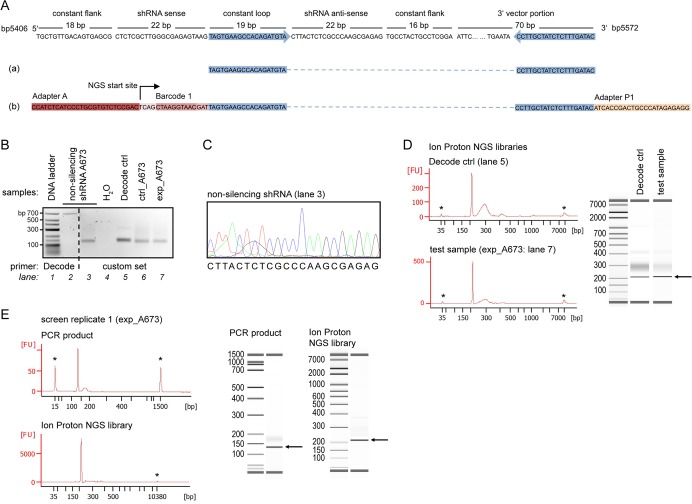
Anti-sense shRNA recovery and Ion Proton NGS library preparation.(A) Excerpt of the GIPZ plasmid sequence with non-silencing shRNA insert indicating primer locations, anti-sense shRNA amplicon (a), and Ion Proton NGS template (b). (B) Gel electrophoresis of anti-sense shRNA PCR products. A673 cells containing non-silencing shRNA (lanes 2–3) were processed identical to A673 test samples (lanes 6–7). For Decode ctrl template (lane 5), cDNA was transcribed from lentiviral particles. Decode Primer PCR (lane 2) followed its manufacturer’s protocol, for custom PCR see Materials and Methods. (C) Sanger-sequence of PCR product recovered from A673 cells that contained non-silencing shRNA (B; lane 3). (D) Bioanalyzer electrophoresis profiles representative of Ion Proton NGS libraries of Decode ctrl and test samples (B; lanes 5 and 7). (E) Bioanalyzer profiles representative of purified PCR products and Ion Proton NGS libraries of screen replicate 1. FU = fluorescent units; asterisk (*) indicates marker; arrow indicates expected fragment size. Profiles of additional samples are provided in S2 Fig.